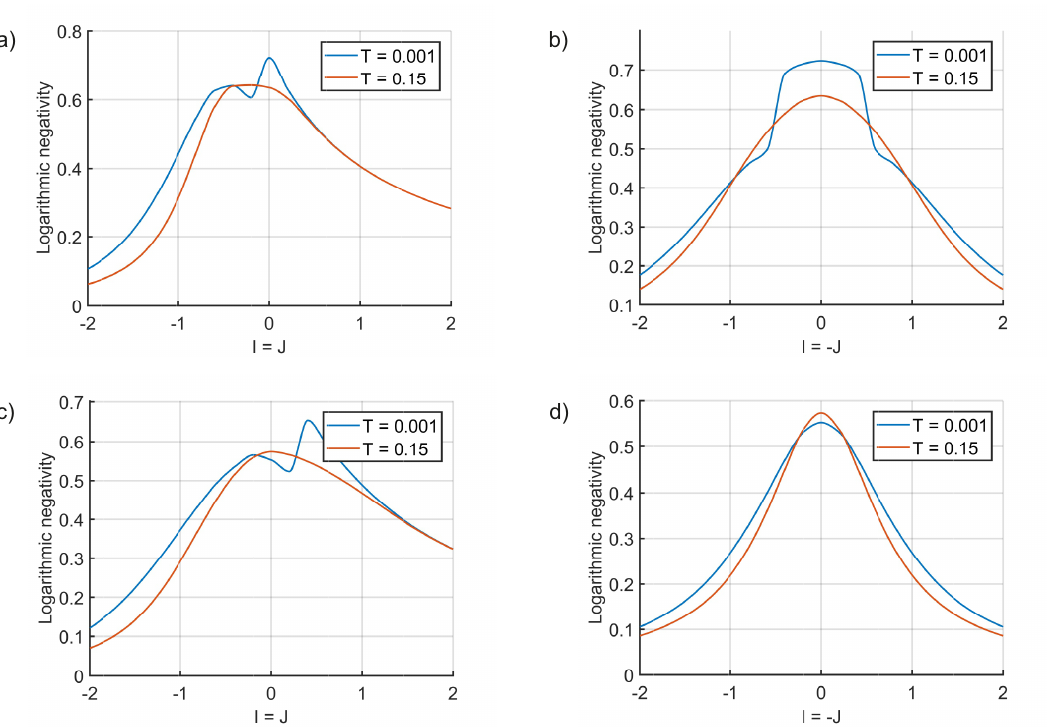
Figure 6: (a) The evolution of the entanglement with temperature for the main di- agonal of the I − J plane, and negative K = − 1 in the presence of staggered fields in both subsystems. The low- T two-peak structure caused by the concerted action of the intersubsystem exchange and the staggered fields erodes with the increasing T . At high T one broad maximum is formed. Compare Fig. 3(a) without fields. (b) The same for the antidiagonal of the I − J plane. The non-monotonic behavior of the entanglement with temperature is seen at both sides of the main peak. Compare Fig. 3(b) at zero field. (c) Evolution of the entanglement with temperature for the main diagonal of the I − J plane, and positive K = + 1 in the presence of staggered fields in both subsystems. The shape of this plot is similar to that in Fig. 6(a): the low- T two-peak structure erodes with the increasing T , forming one broad peak. Compare to Fig. 3(c) at zero field. (d) The same for the antidiagonal of the I − J plane. In contrast to Fig. 6(b), the non-monotonic behavior of the entanglement with temperature is seen just at the peak. Compare to Fig. 3(d) at zero